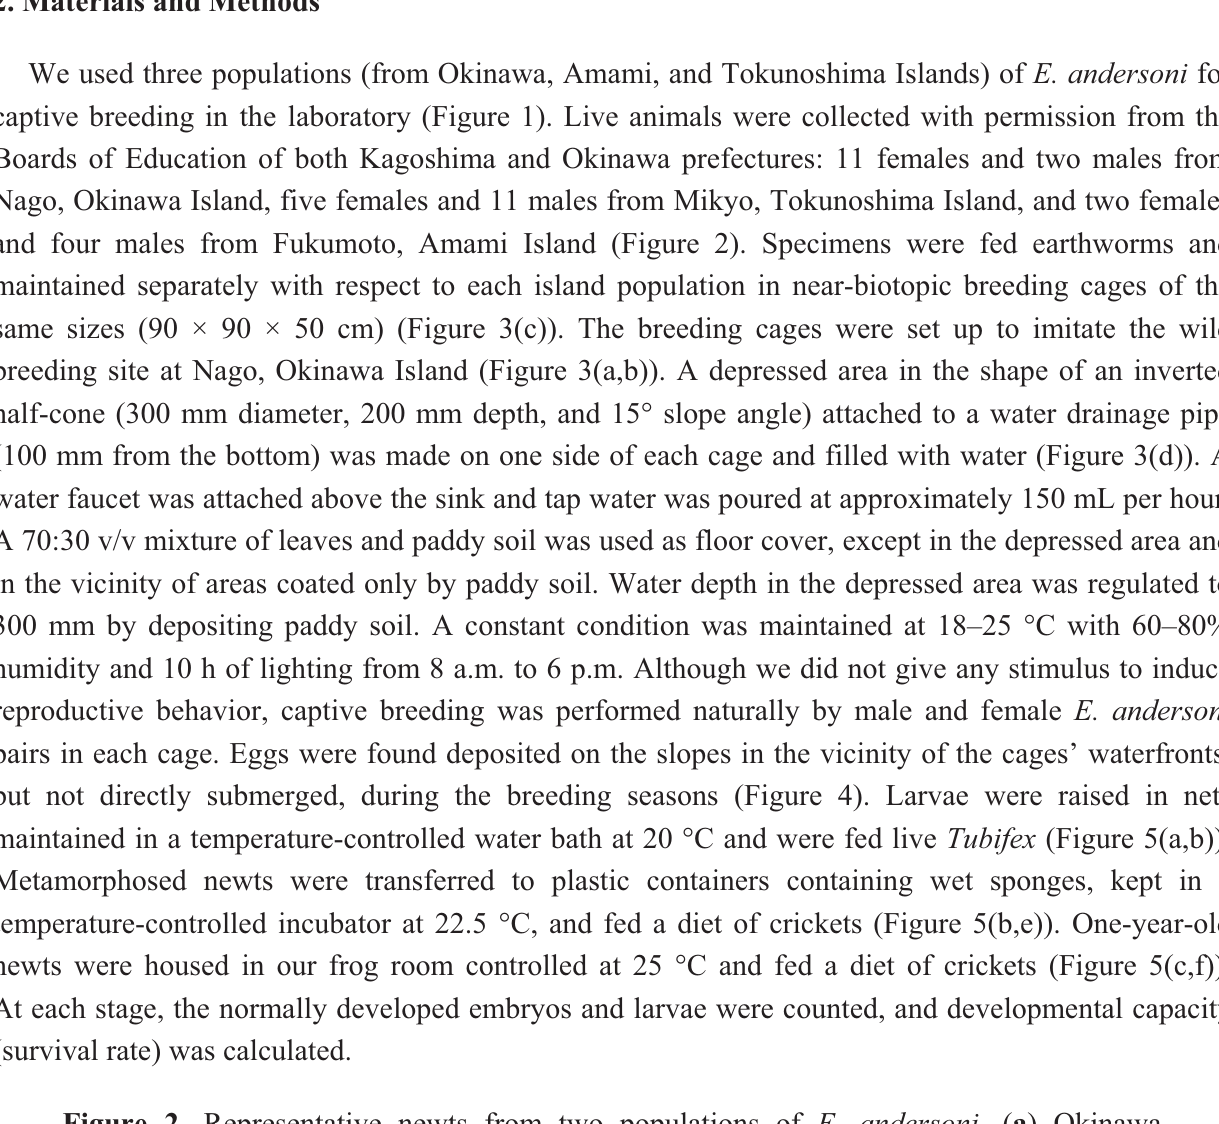
Figure 2. Representative newts from two populations of E. andersoni . ( a ) Okinawa population. ( b ) Tokunoshima population. Scale bar = 2.0